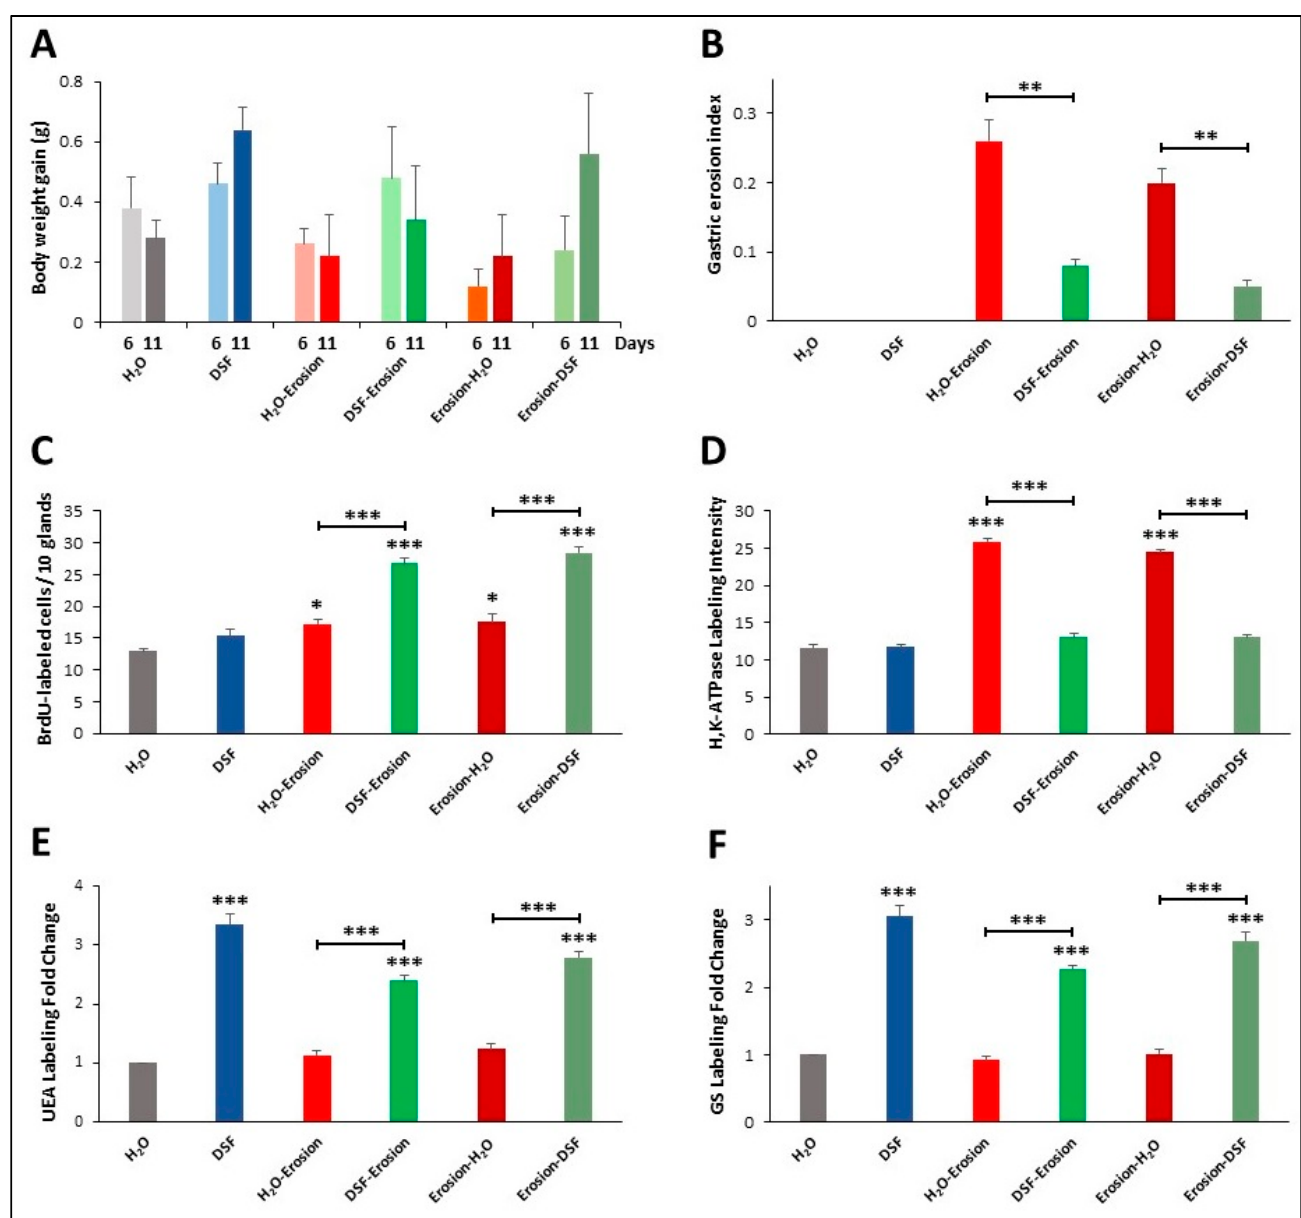
Figure 11. Characterization of the 6 groups of mice of the second protocol of multiple-ASA-gavage erosion model. The graphs show body weight gain ( A ), gastric erosion index ( B ), BrdU-labeling ( C ), H + ,K + -ATPase immunolabeling intensity ( D ), UEA lectin labeling ( E ) and GS lectin labeling ( F ). In all graphs, data are presented for each group of 5 mice as mean ± SE. Asterisks above the columns compare the value of that column with the H 2 O control group and on the horizontal lines compare adjacent paired groups. * p < 0.05, ** p < 0.01, *** p < 0.001.